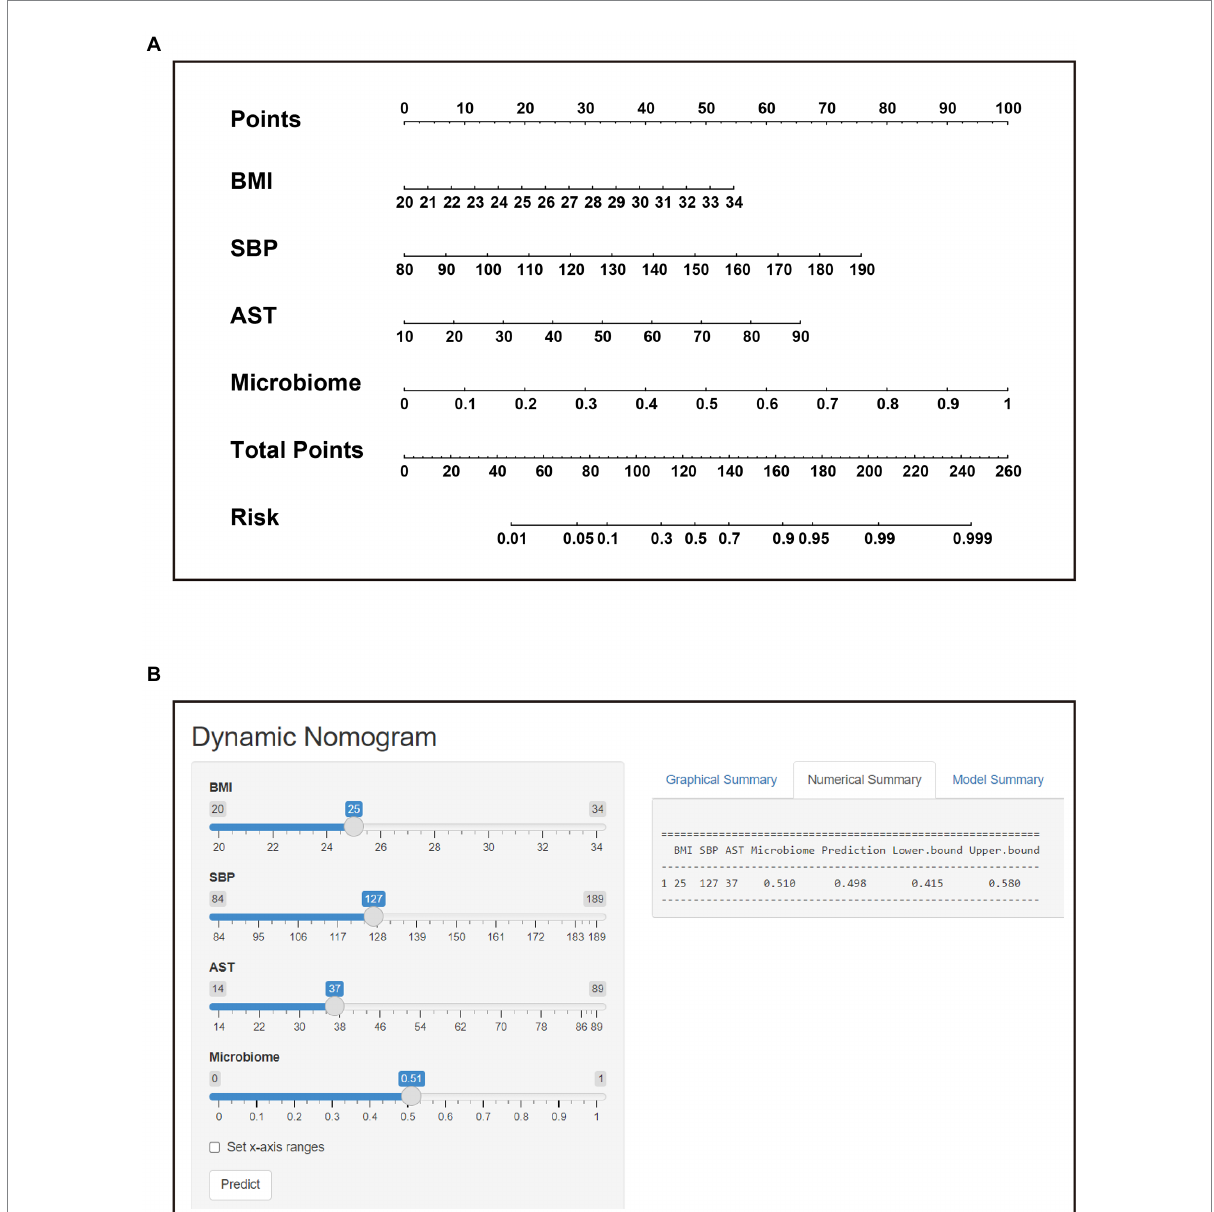
FIGURE 6 Nomogram and its corresponding web page. (A) Construction of the nomogram based on BMI, SBP, AST and Microbiome to assign the probability of developing STEMI. (B) Web-based risk calculator (Dynamic Nomogram (shinyapps.io)) to predict incidence rate of